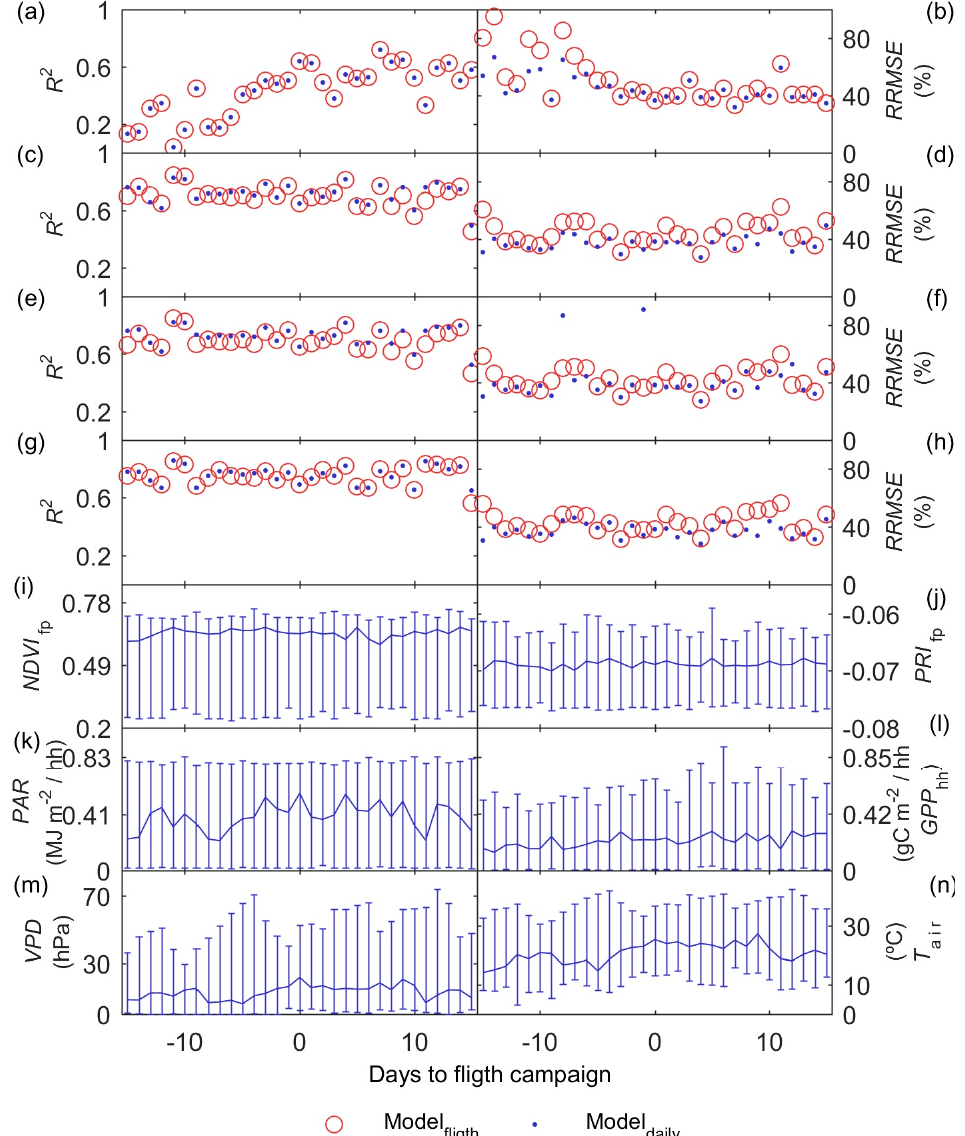
Figure 5. Predicted-Observed statistics of the models: MOD1 ( a , b ); MOD2 ( c , d ); MOD3- PRI ( e , f ); and MOD4 ( g , h ). Daily ranges of variation and median of the input variables: NDVI fp ( i ); PRI fp ( j ); photosynthetically active radiation ( PAR ) ( k ); and measured: GPP hh ( l ); VPD ( m ); and T air ( n ).